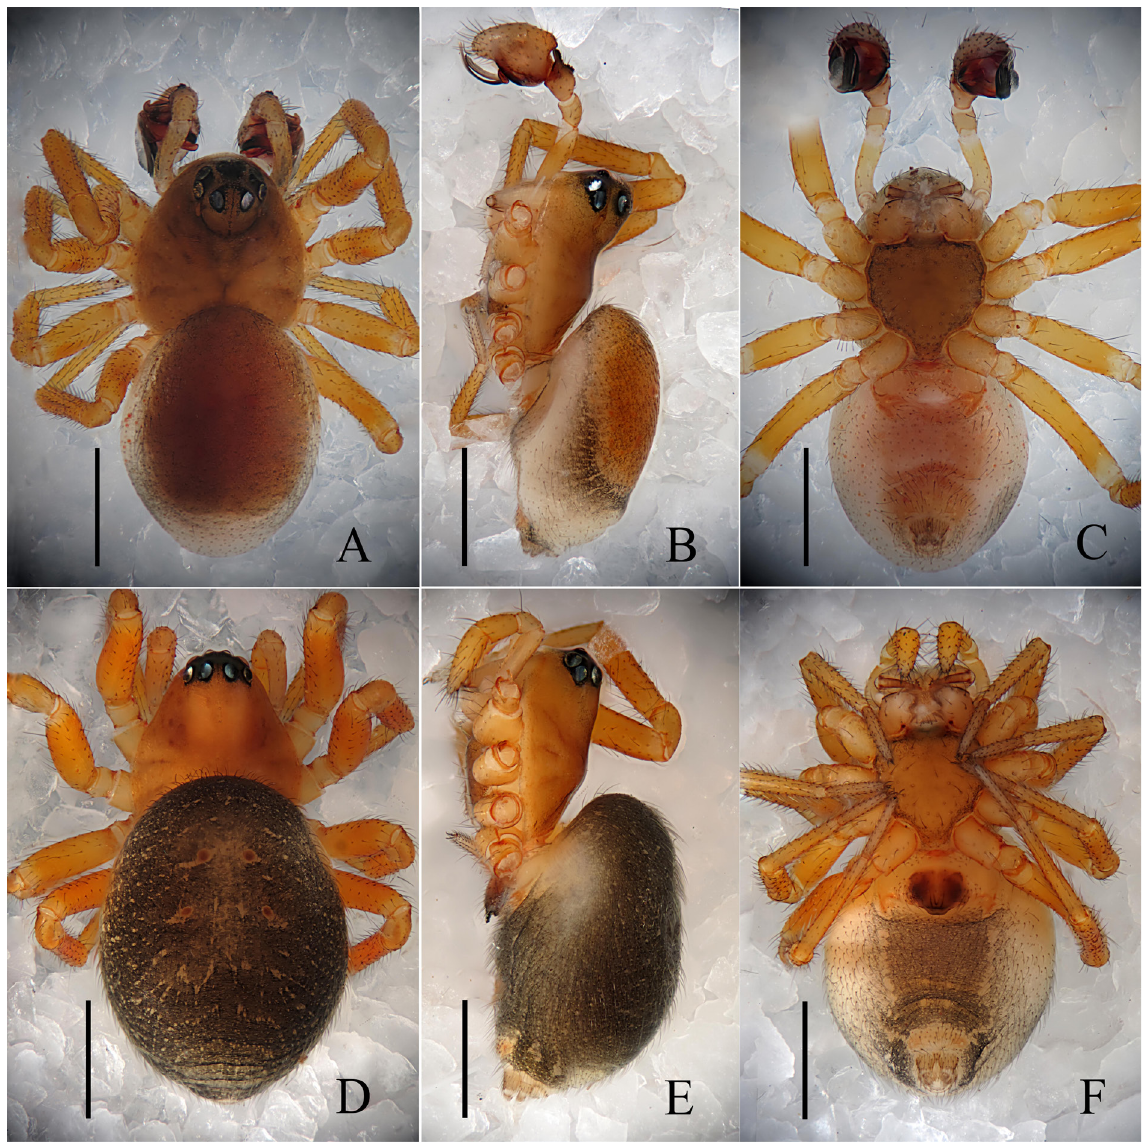
Fig. 10. Yuelushannus barbatus sp. nov., male, holotype, YLS–17–0301~01 (A–C) and female, allotype, YLS–17–0301~02 (D–F). A , D . Habitus, dorsal view. B , E . Habitus, lateral view. C , F . Habitus, ventral view. Scale bars: 0.5